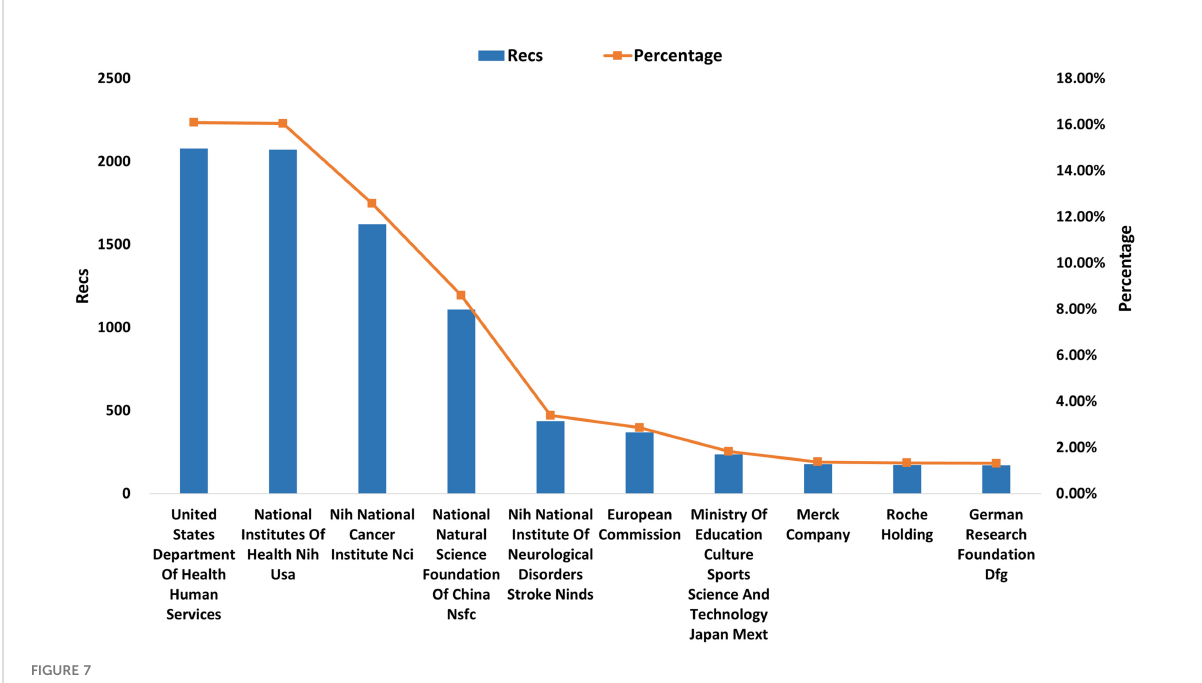
FIGURE 7 The top 10 productive funding agencies in the TMZ